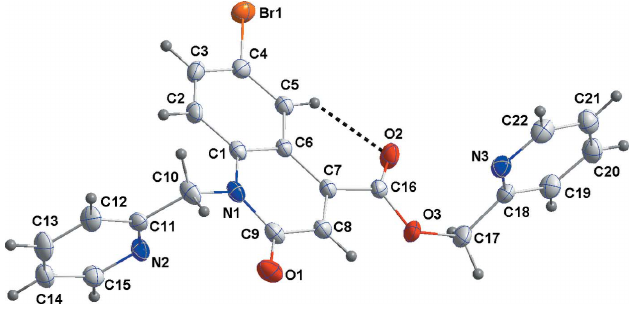
Figure 1 The title molecule with the labeling scheme and 50% probability ellipsoids. The intramolecular C—H (cid:3)(cid:3)(cid:3) O hydrogen bond is shown as a dashed line.